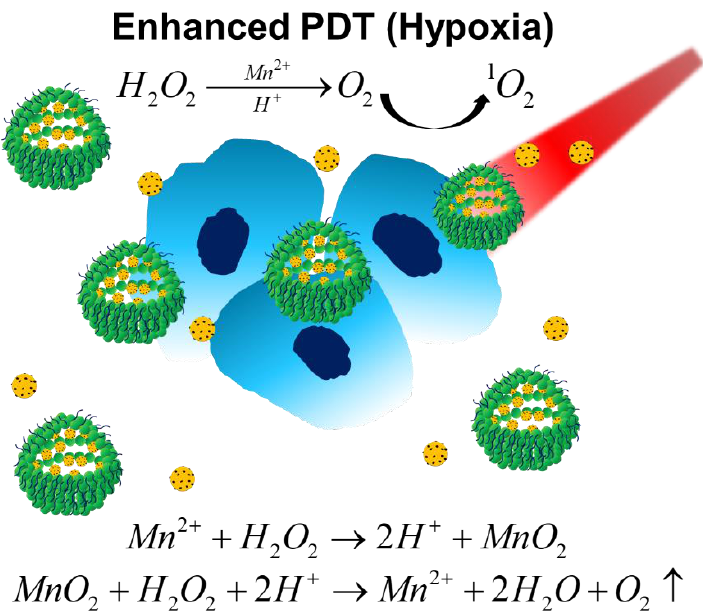
Figure 3. Schematic illustration of Mn–CD assembly catalyzing the decomposition of H 2 O 2 to oxygen under acidic/hypoxic microenvironments, which exerts oxygen-enhanced PDT. Reproduced with permission [45]. Copyright 2018, Wiley-VCH.